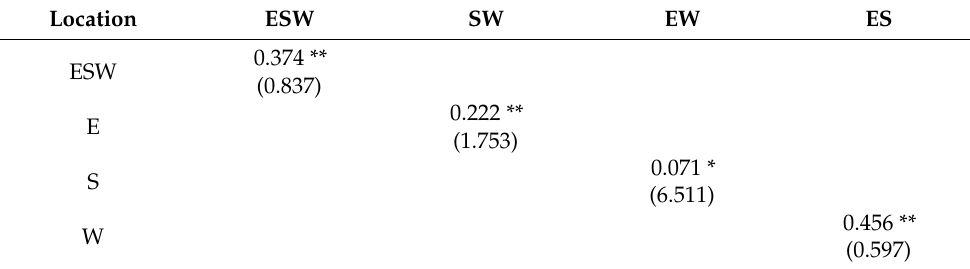
Table 2. Mitochondrial genetic differentiation analysis based on mtDNA control region using pairwise